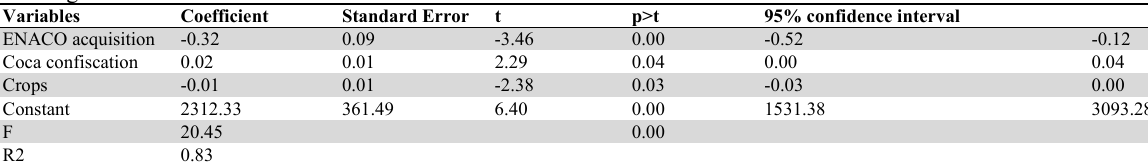
Selected variables Variables √ √ Crops √ Coca leaf confiscation √ Constant √ √ Table 3 reveals that the current analysis selected the cross-validation method. The CV had higher prediction power and lower MSE than the adaptive method. Hence ENACO acquisition, crops and coca leaf confiscation were selected as the best varia- bles to predict the dependent variable, as the Table 4 shows. OLS Regression